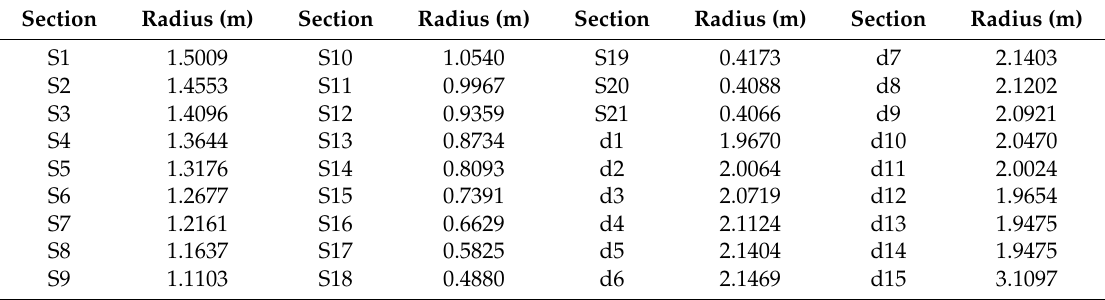
Figure 1. Configuration of computational domains (in meter): ( a ) Vertical and overhead views; ( b ) Overall view. Table 1. Radius of the sections.